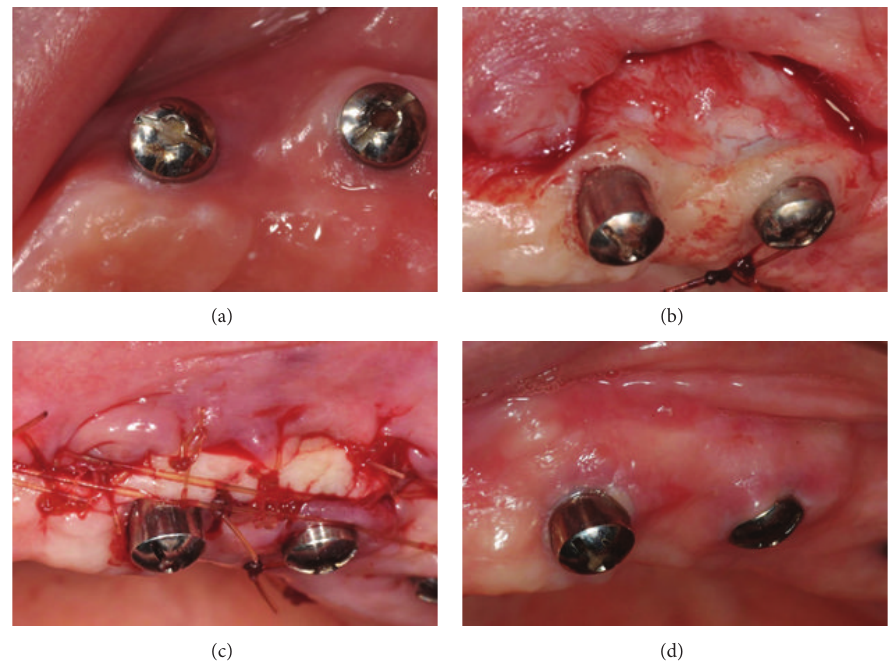
Figure 4: (a) Presurgical appearance of two implants with 1mm of buccal keratinized tissue. (b) Partial thickness flap on the recipient bed prepared for the FGG. (c) Interrupted and horizontal mattress sutures to stabilize the FGG obtained from the palate. (d) Three-month follow- up showing an increase of 2-3mm of keratinized